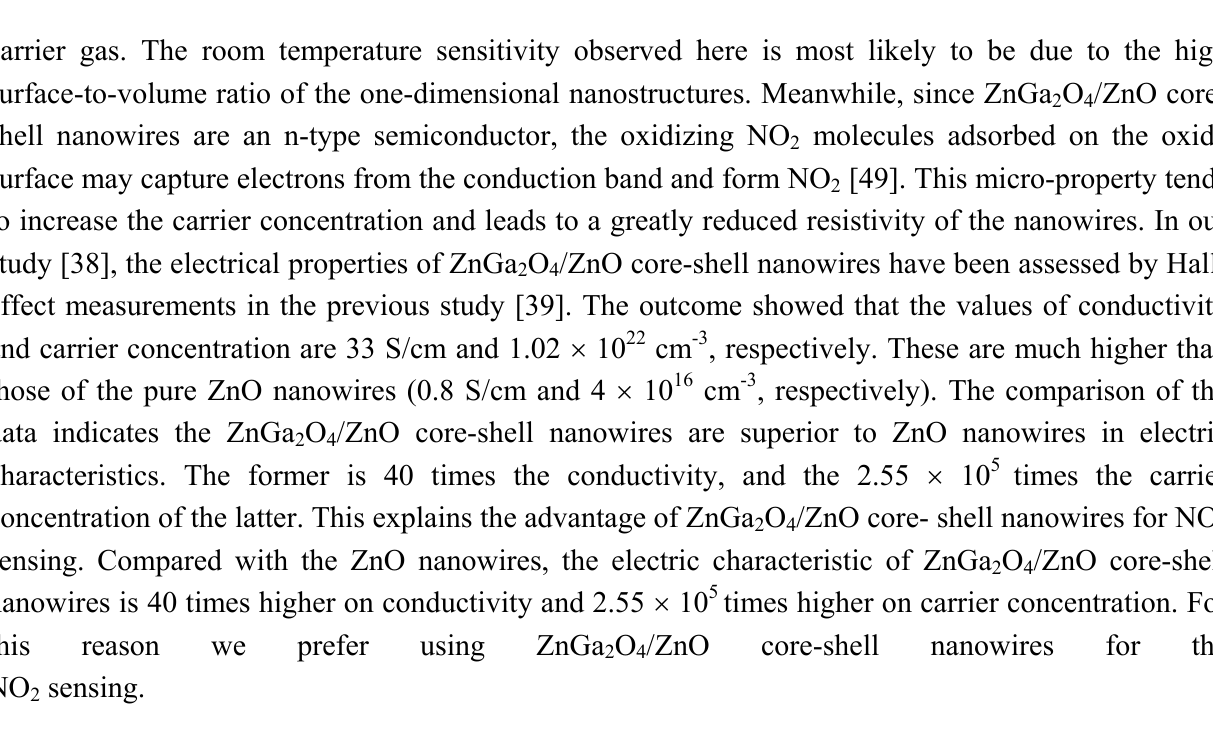
Figure 7. Dynamic responses of ZnGa nanowire sensor to 100 ppm NO